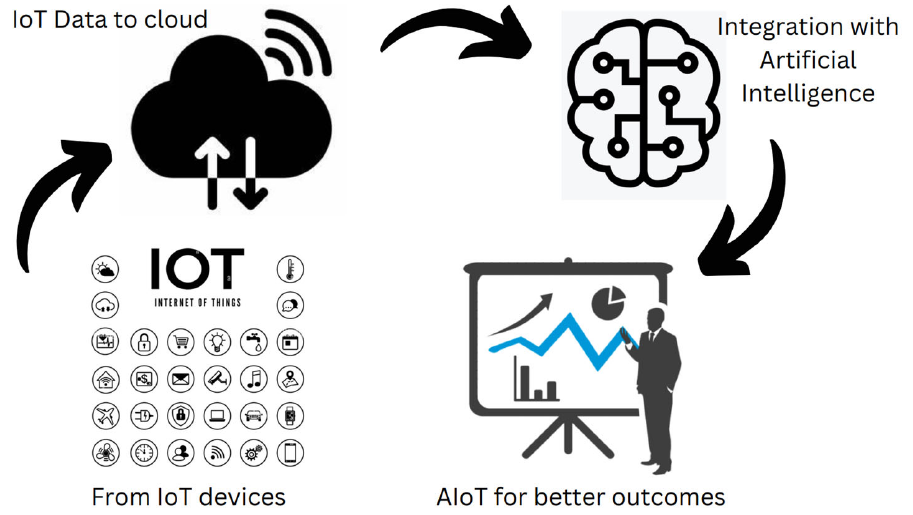
Figure 1. From smart “Things” in IoT systems to the adoption of AI techniques.